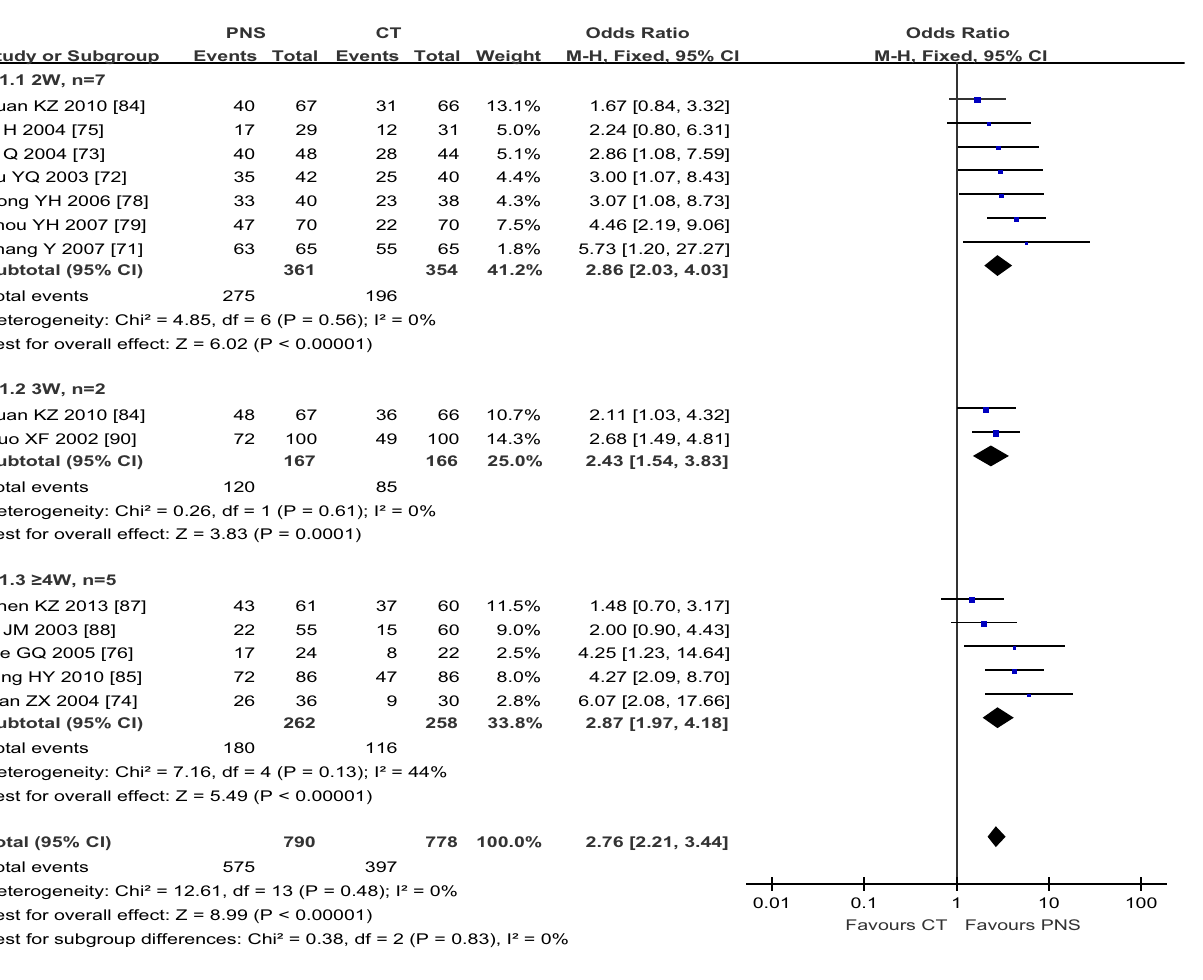
PNS and CT groups ( P <0.00001). And the differences in ER between the two treatment groups were significant at 2, 3, and 4weeks ( P <0.00001, each) after PNS treatment. PNS, Panax notoginseng saponin; CT, Current treatment.